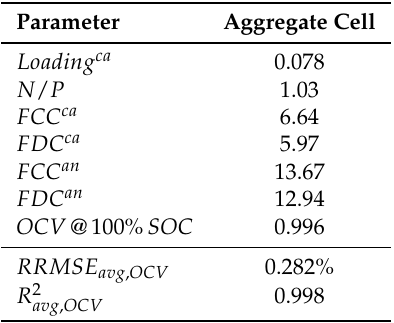
Table 4. OCV calibration optimization results for the aggregate cell.